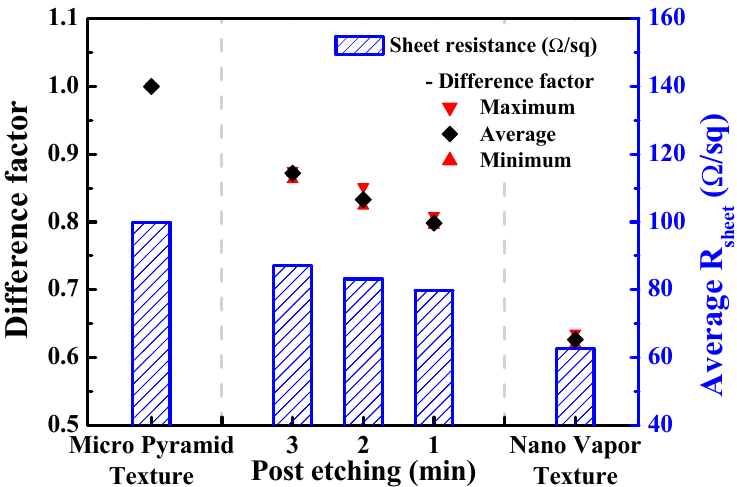
Figure 3. Change in emitter sheet resistance after phosphorus doping process, according to the variation in surface morphology.